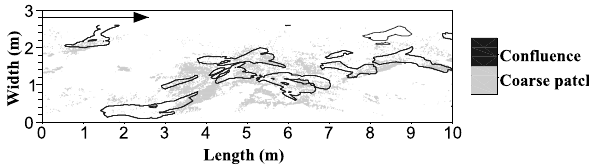
Figure 10. Confluence and coarse patches map. Black lines are the boundaries of confluence areas over 40h. Gray dots are coarse